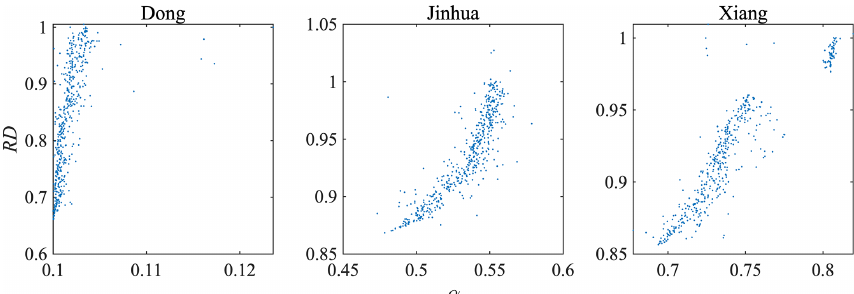
Figure 7. Relationship between α and RD in the three cases.